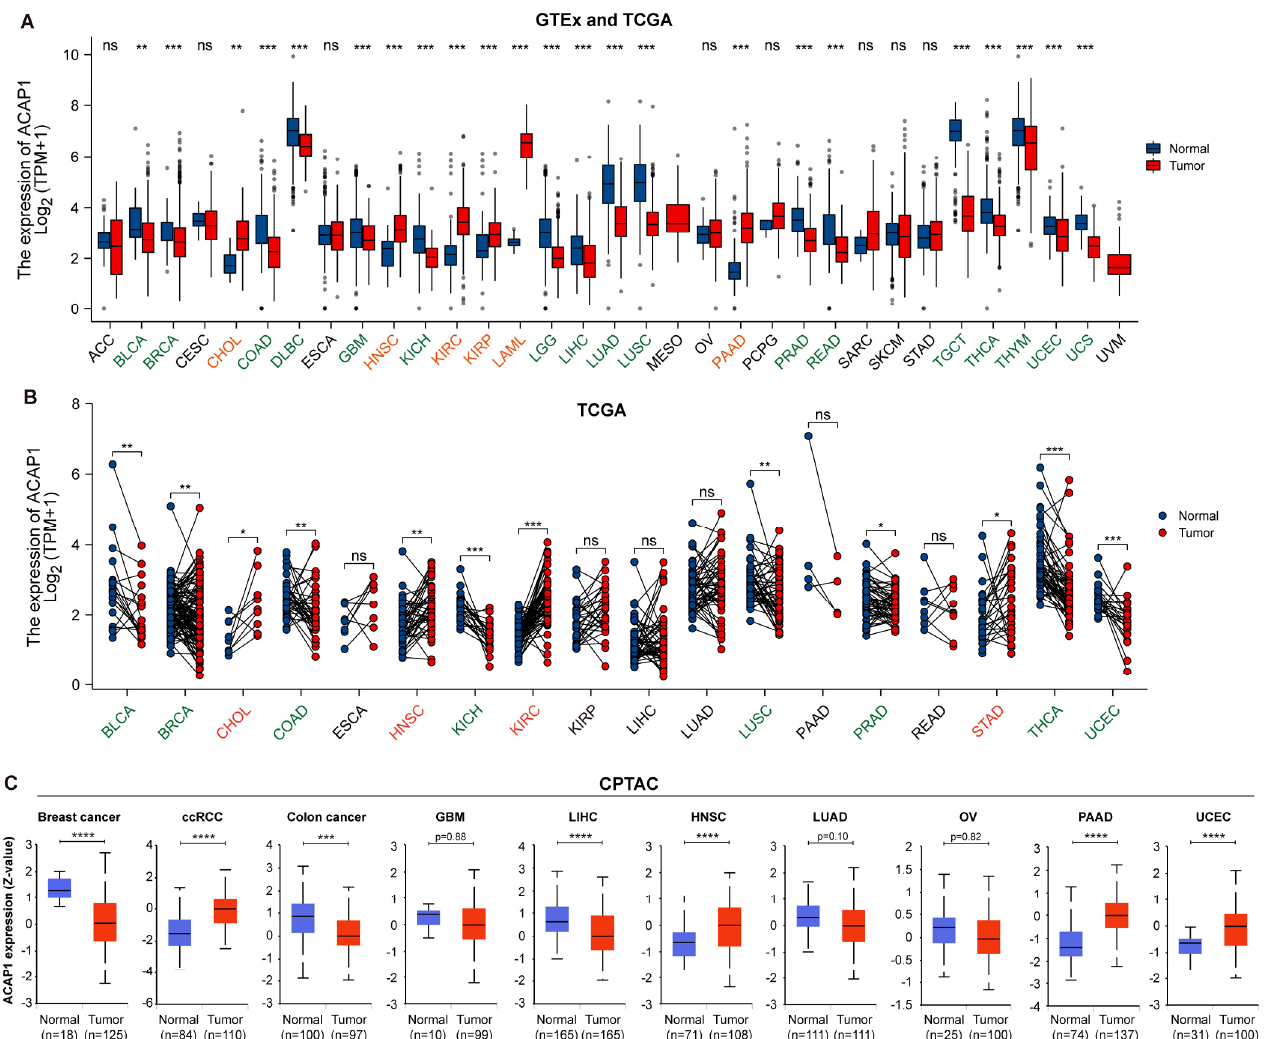
Figure 3. Pan-cancer analysis of ACAP1 expression in human cancer. ( A ) Comparing of ACAP1 mRNA levels in tumor vs. normal samples across TCGA cancer types by combing the TCGA and GTEx data. ( B ) Paired comparison of ACAP1 mRNA levels in tumor vs. normal samples in TCGA. Green: decreased ACAP1 expression in tumors; Red: elevated gene expression in tumors. ( C ) Comparison of ACAP1 protein levels in tumor vs. normal samples across all cancer types available in CPTAC using UALCAN webtool. **** p < 0.0001, *** p < 0.001, ** p < 0.01, * p < 0.05, ns (non-significant).